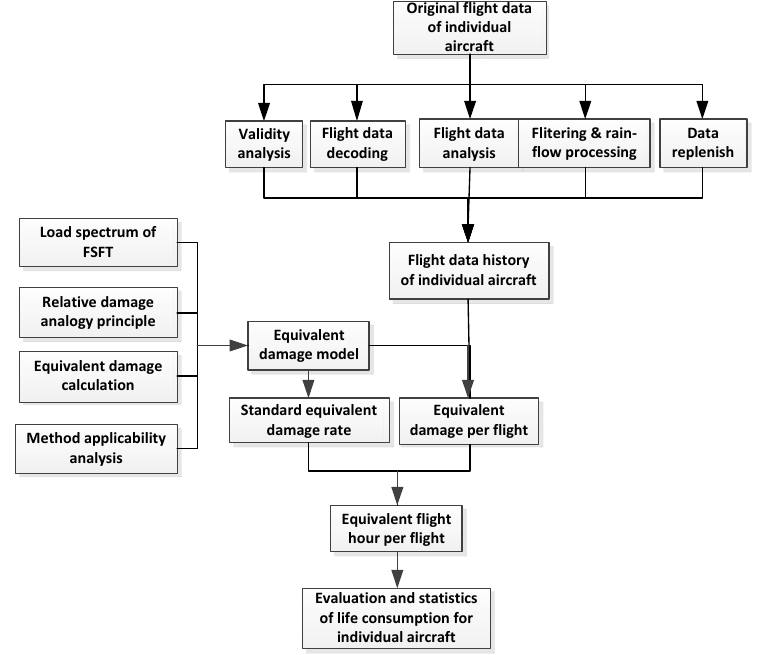
Figure 5. Process of individual aircraft tracking and life monitoring.